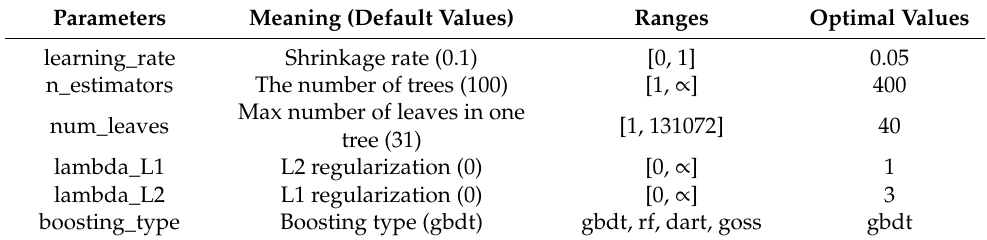
Figure 2. The relationship between regression error and n_estimators in the Light Gradient Boosting Machine (LightGBM) model. Table 4. The description of the imperative parameters of the LightGBM model and the optimal values after tuning.